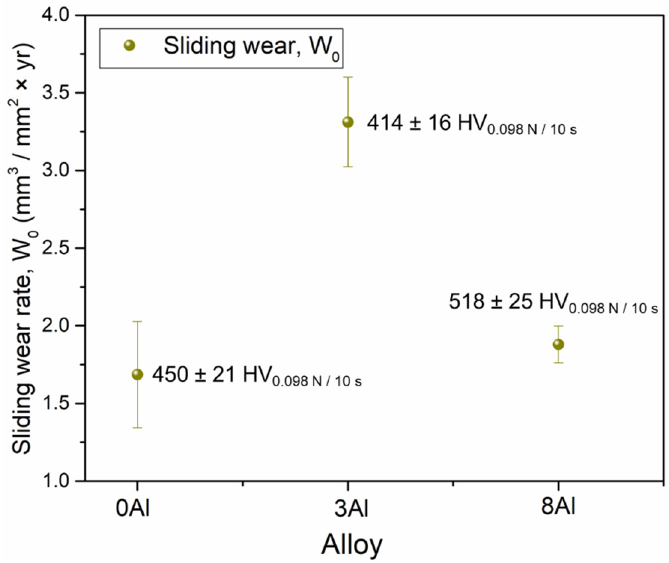
Figure 6. Wear rates of the materials under pure sliding wear, W 0 .